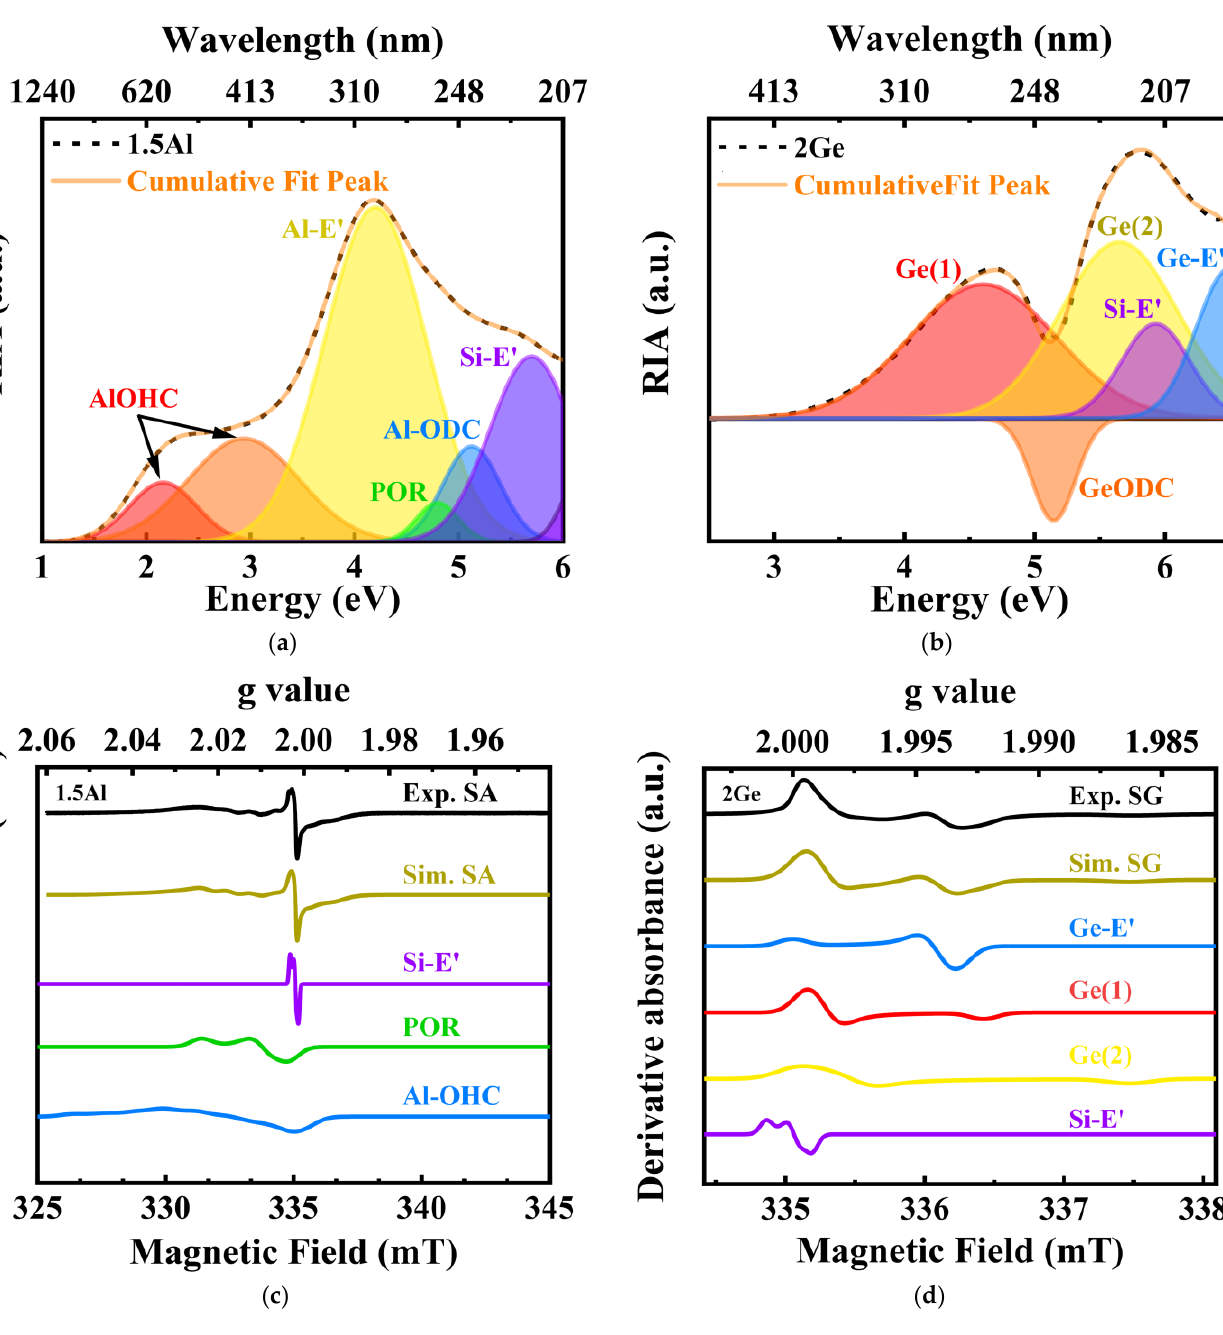
Figure 7. Gaussian decomposition of RIA of ( a ) Al-doped and ( b ) Ge-doped glasses; CW-EPR spectra of irradiated ( c ) Al-doped and ( d ) Ge-doped glasses.